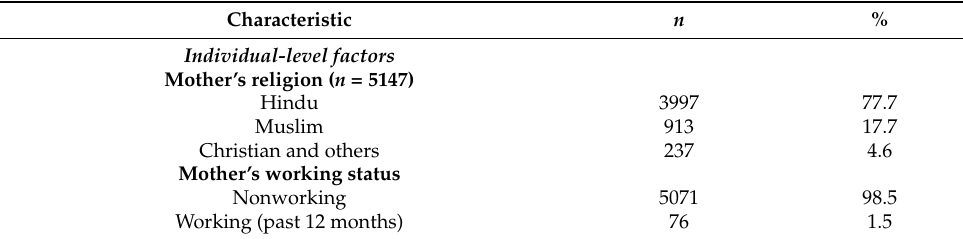
Table 1. Characteristics of the study population, India ( n =